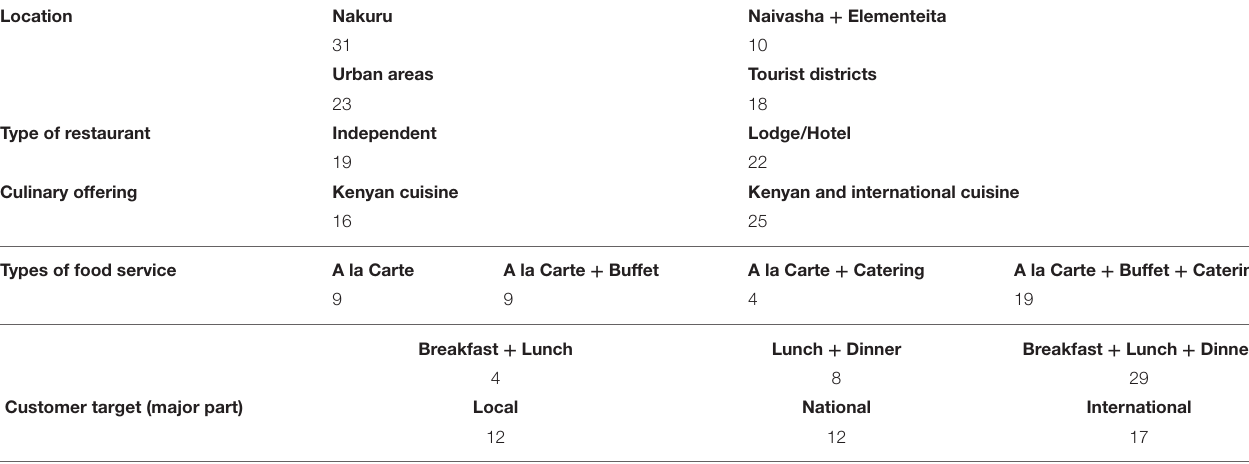
TABLE 1 | Characteristic of the sample.